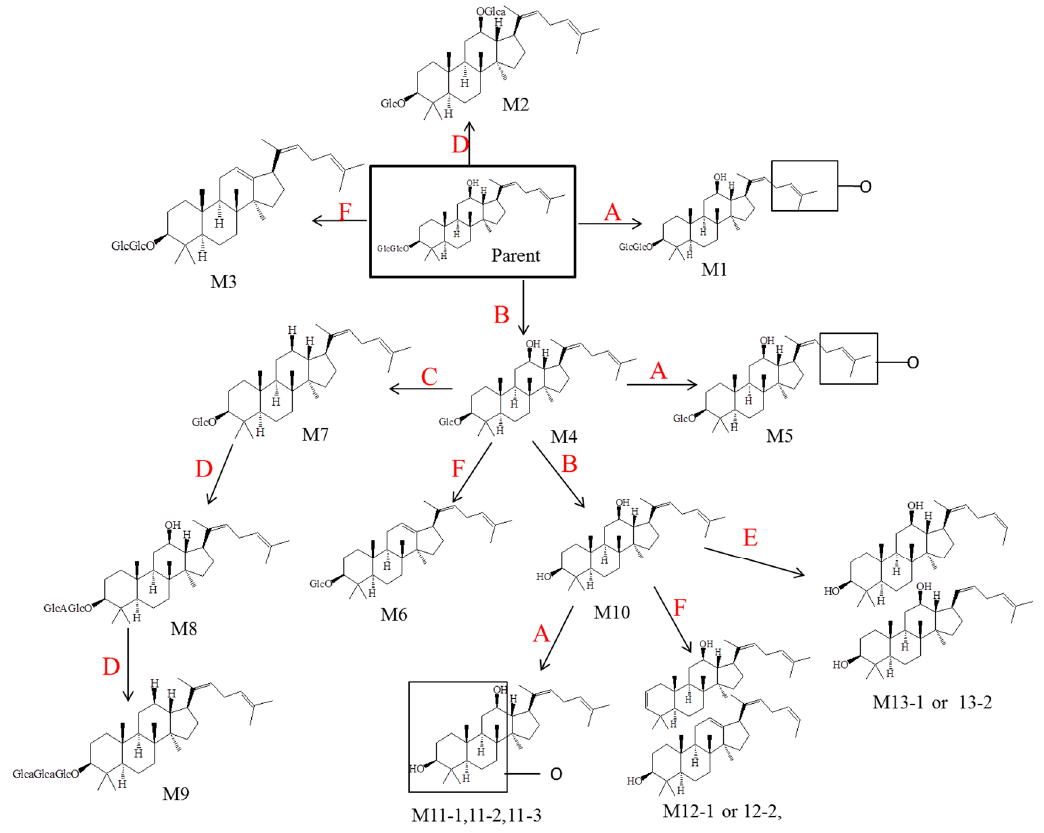
Figure 6. Major metabolic pathways proposed for ginsenoside Rg5. (A represents for oxidation, B deglycosylation, C deoxidation, D glucuronidation, E demethylation, F dehydration).